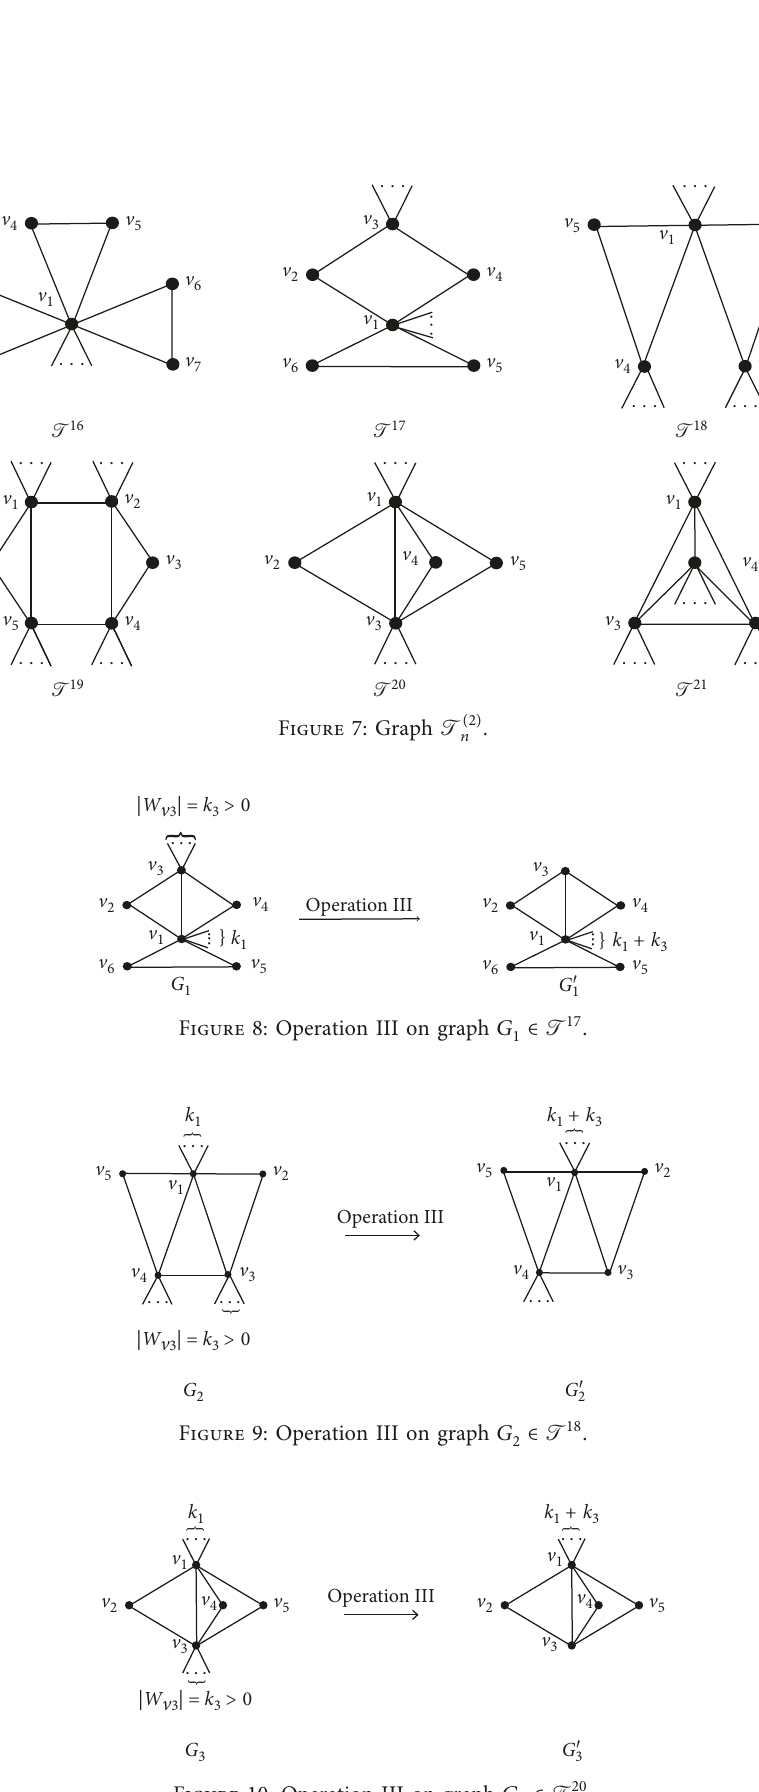
Figure 10: Operation III on graph G